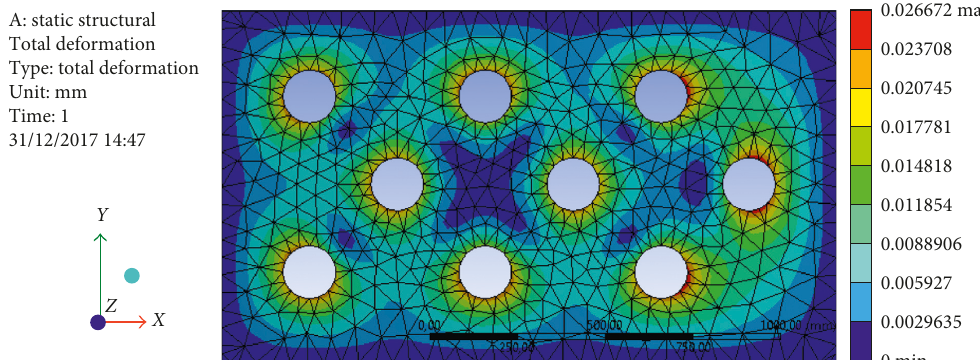
Figure 16: Redistribution and magnitude of displacement around 9 holes drilled in the staggered mesh.